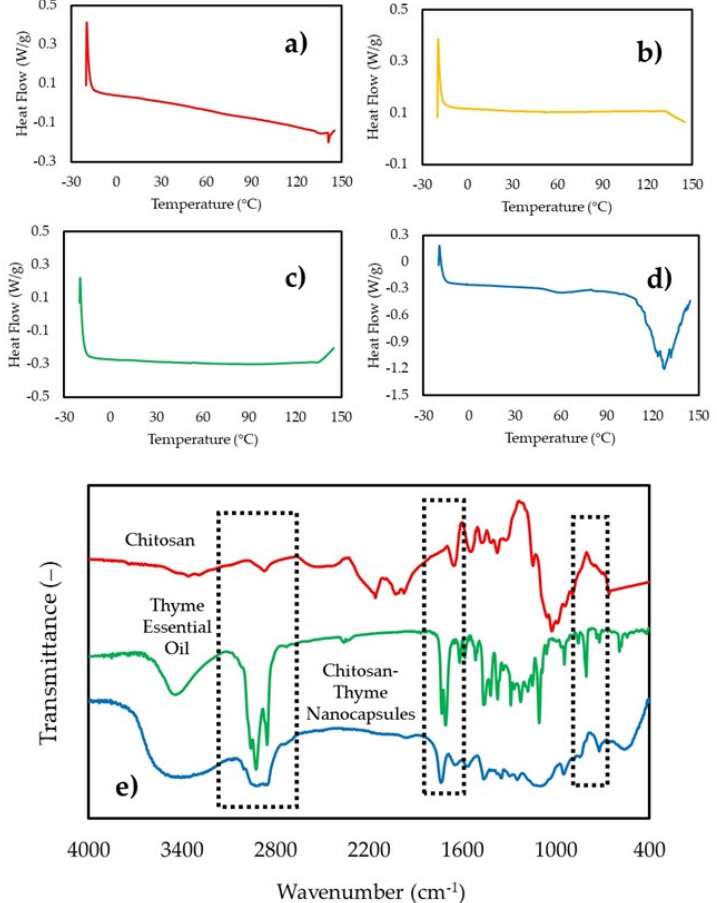
Figure 3. Differential scanning calorimetry for the components of the nanocapsules ( a ) chitosan, ( b ) TPP, ( c ) thyme essential oil, and ( d ) chitosan-thyme nanocapsules, and ( e ) infrared spectra of the chitosan nanocapsules obtained by ionic gelation and its components.